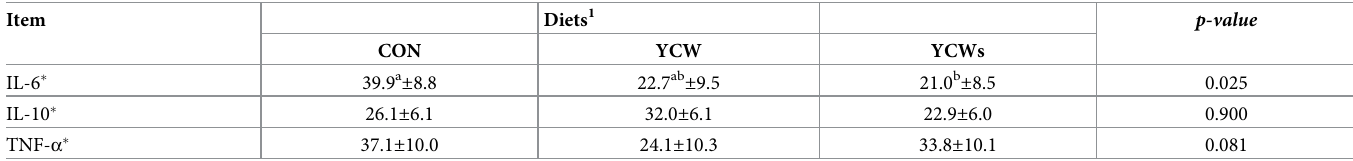
Table 8. Serum cytokines concentrations (pg/mL) of dogs fed diets with the addition of different yeast cell wall preparations (mean and standard error of the mean).